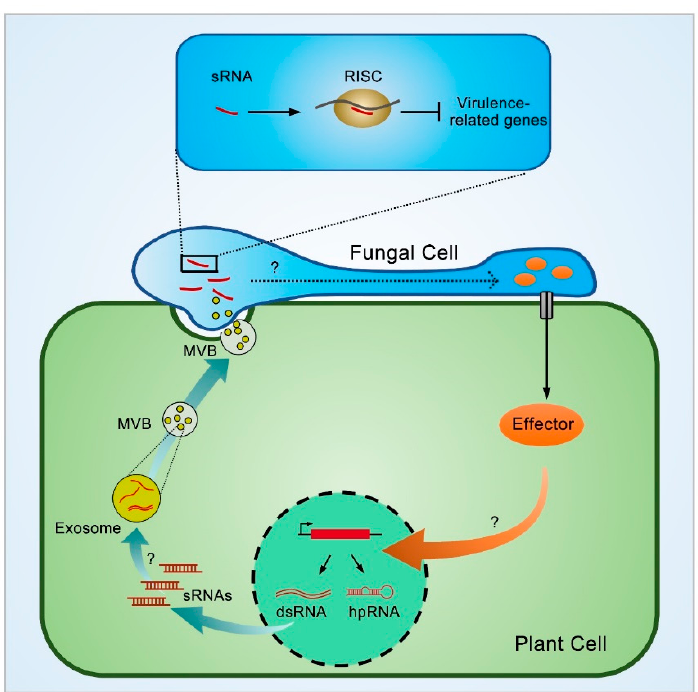
Figure 2. A working model of trafficking sRNA-dependent regulation of plant immunity during plant–fungus interaction. DsRNA and folded hairpin (hp) RNA are firstly produced from exogenous transgenes or endogenous host genes, and then sRNAs are processed by Dicer from the above dsRNA precursors. Through an unknown mechanism, specific sRNAs are loaded into exosomes with unknown isoform. sRNA-containing exosomes are assembled into multivesicular bodies (MVB) and translocated into fungal cell through transcytosis-mediating exosome release. Then plant trafficking sRNAs cooperate with fungal RISC to silence virulence related genes and improve plant resistance. Meanwhile, fungi can secret effectors into plant cells to interfere with host RNA silencing pathway, thereby disrupting host immunity. MVB, multivesicular bodies, RISC, RNA-induced silencing complex. Solid arrow indicates the direction of the working model. The dashed arrow indicates the possible mechanisms.